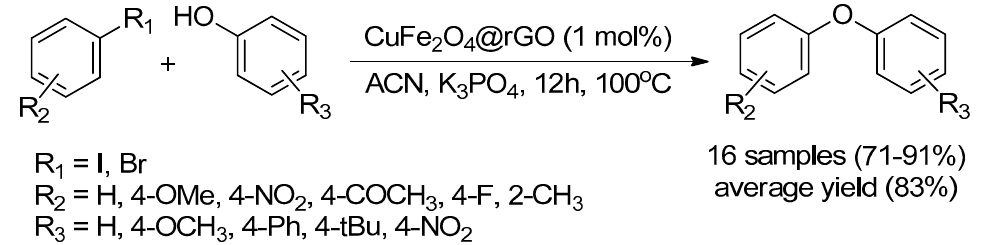
Figure 8. The reusability of the synthesized catalyst and the yield of ether product.